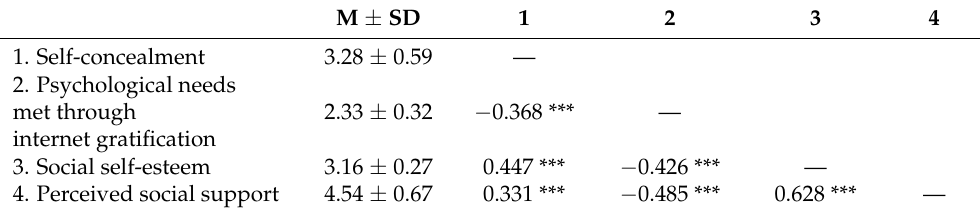
Table 3. Descriptive statistics and correlations among the study variables.